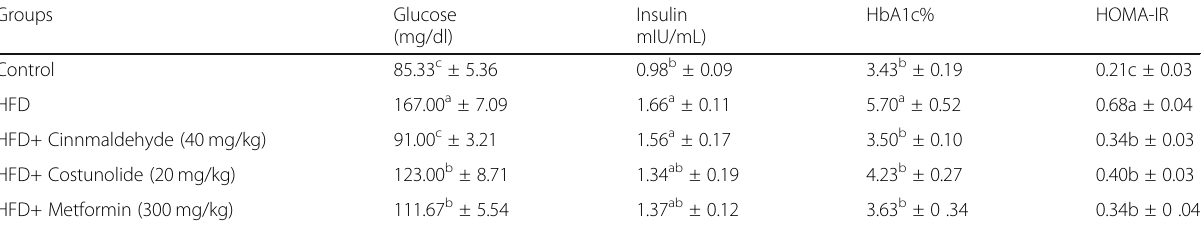
Table 3 Effect of oral administration of cinnamaldehyde and costunolide on fasting blood glucose, insulin, HbA1c % and HOMA-IR in HFD fed rats for 30 days